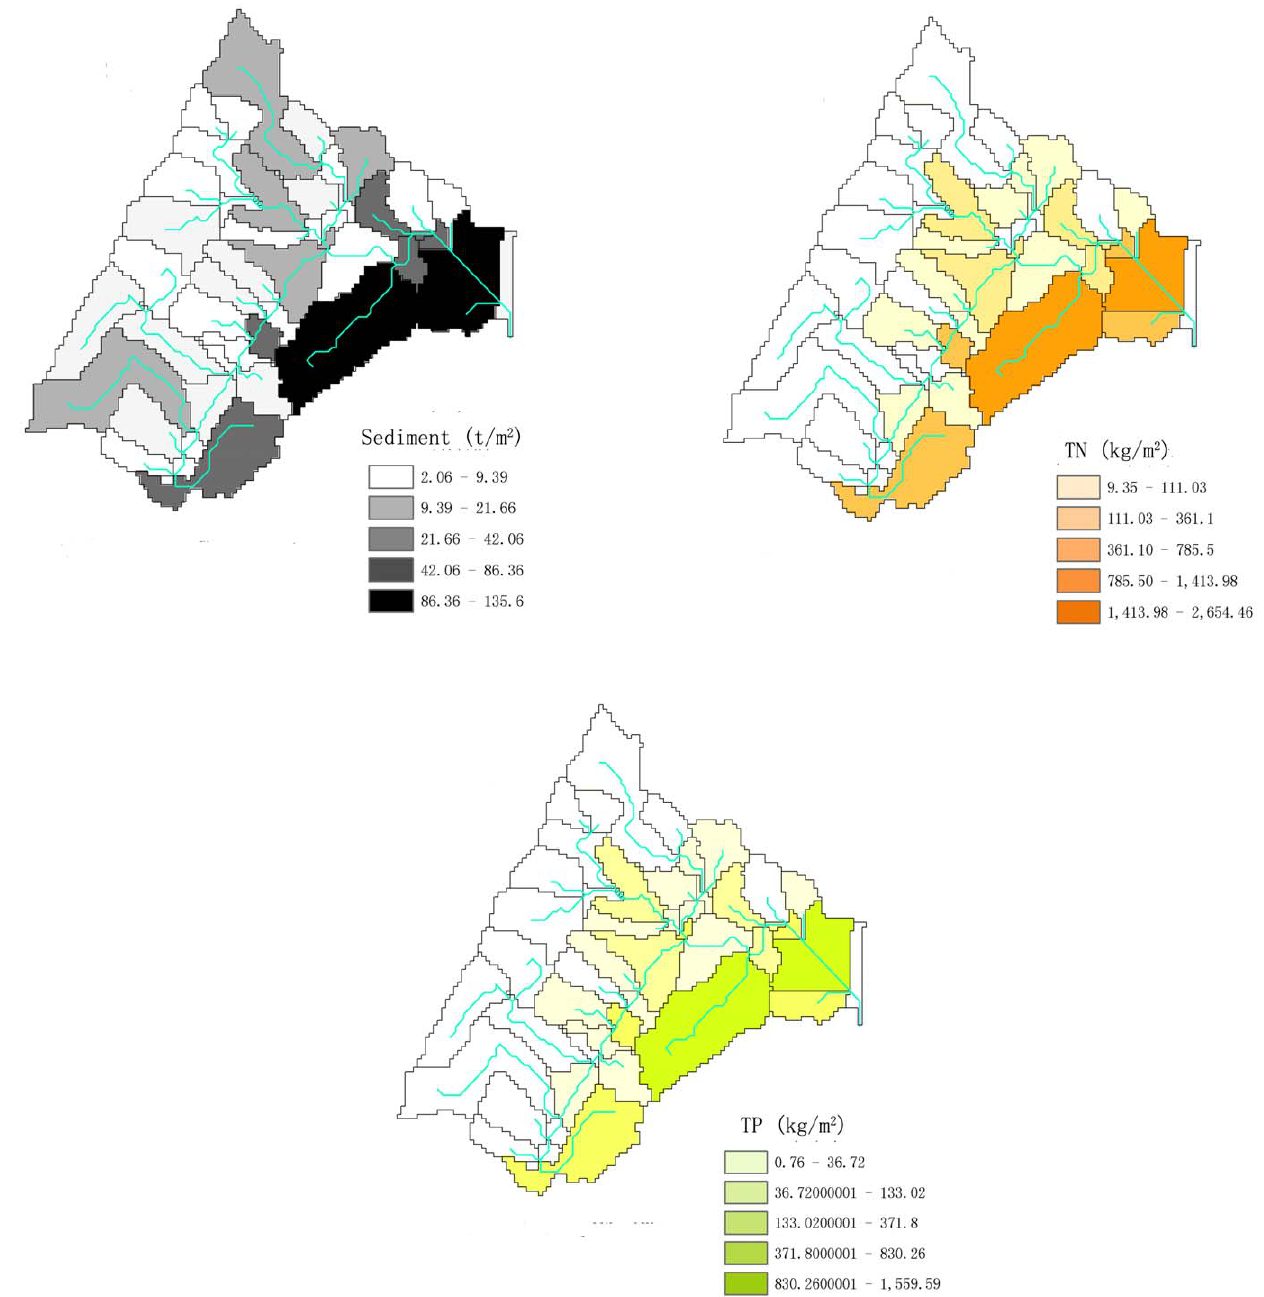
Figure 6. The sediment, NPS-TP and NPS-TN load during the pre-BMP period.